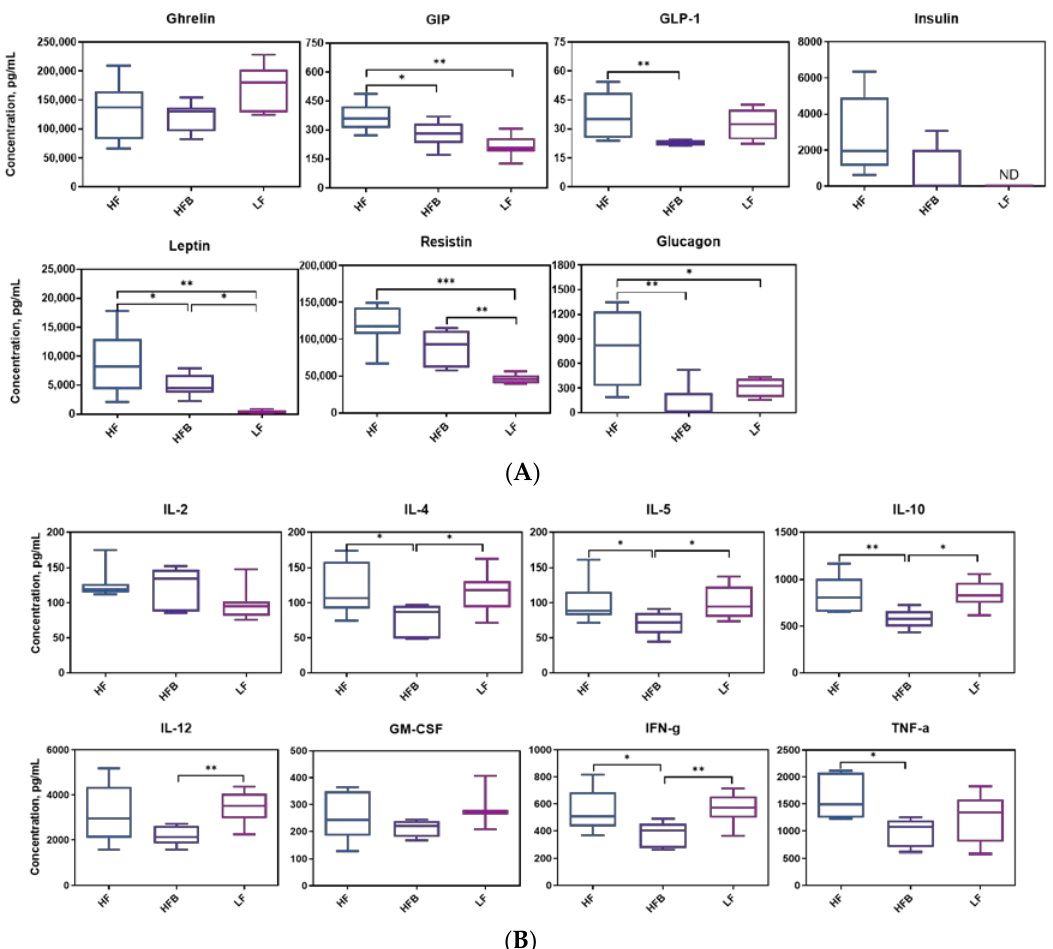
Figure 3. ( A ) Boxplot of plasma biomarkers concentrations related to diabetes and obesity, n = 8/group. ND = not detected. Top edge of the box, 75th percentile; bottom edge, 25th percentile; horizontal bar within box, median; top horizontal bar outside box, maximum concentration; bottom horizontal bar outside box, minimum concentration. * p < 0.05, ** p < 0.01, *** p < 0.001 between groups. ( B ) Concentrations of plasma inflammatory cytokines, n = 8/group. Top edge of the box, 75th percentile; bottom edge, 25th percentile; horizontal bar within box, median; top horizontal bar outside box, maximum concentration; bottom horizontal bar outside box, minimum concentration. * p < 0.05, ** p < 0.01 between groups.